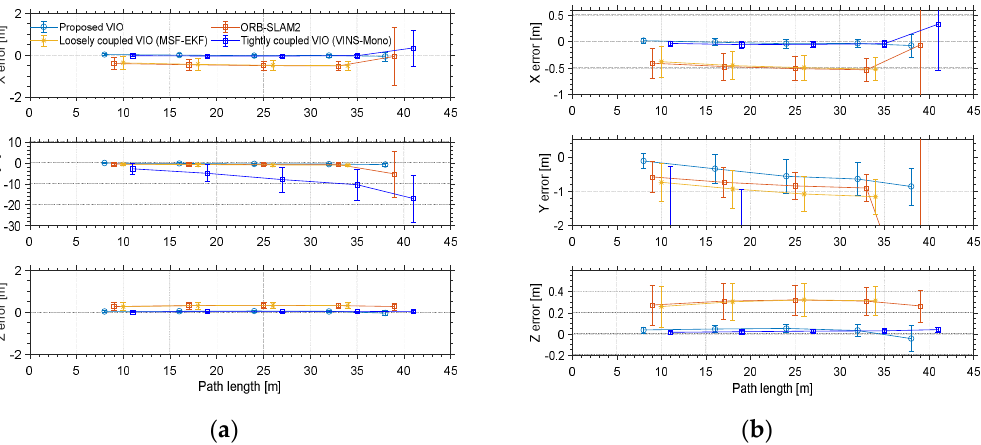
Figure 17. An illustration of value of yaw angle mean and RMSE from different methods. VINS-Mono without output before initialization.